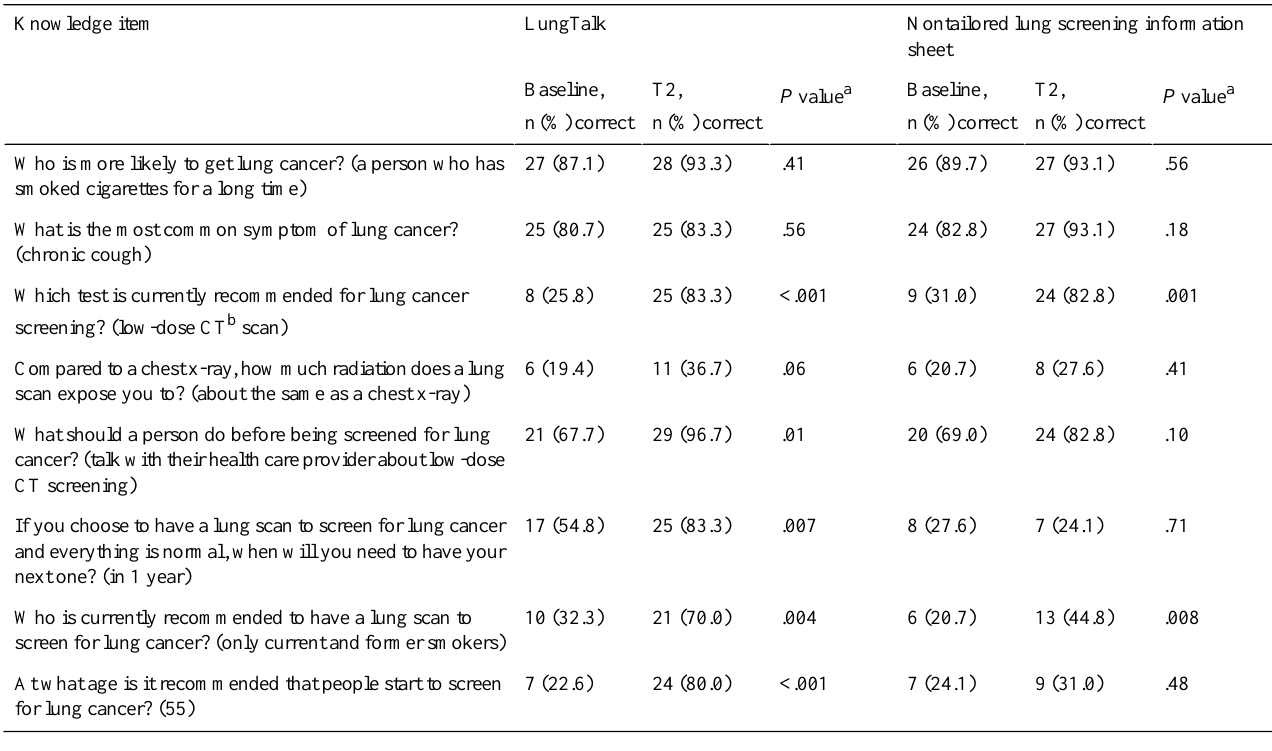
Table 4. Individual knowledge items by within-group